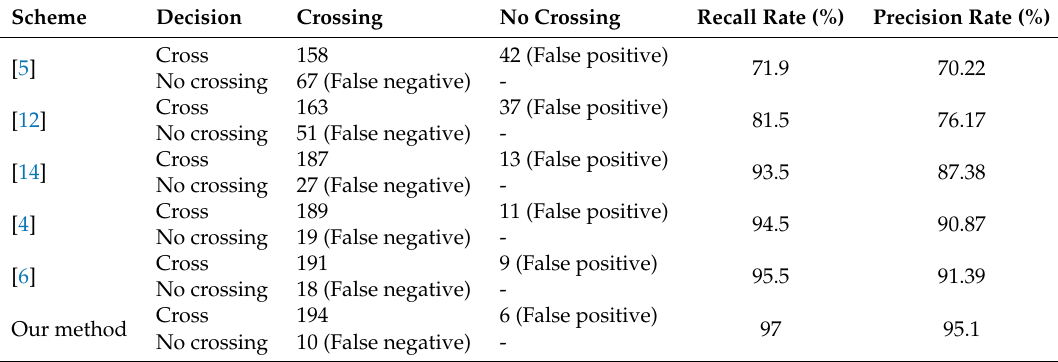
Table 3. Summary of pedestrian crossing detection results using different